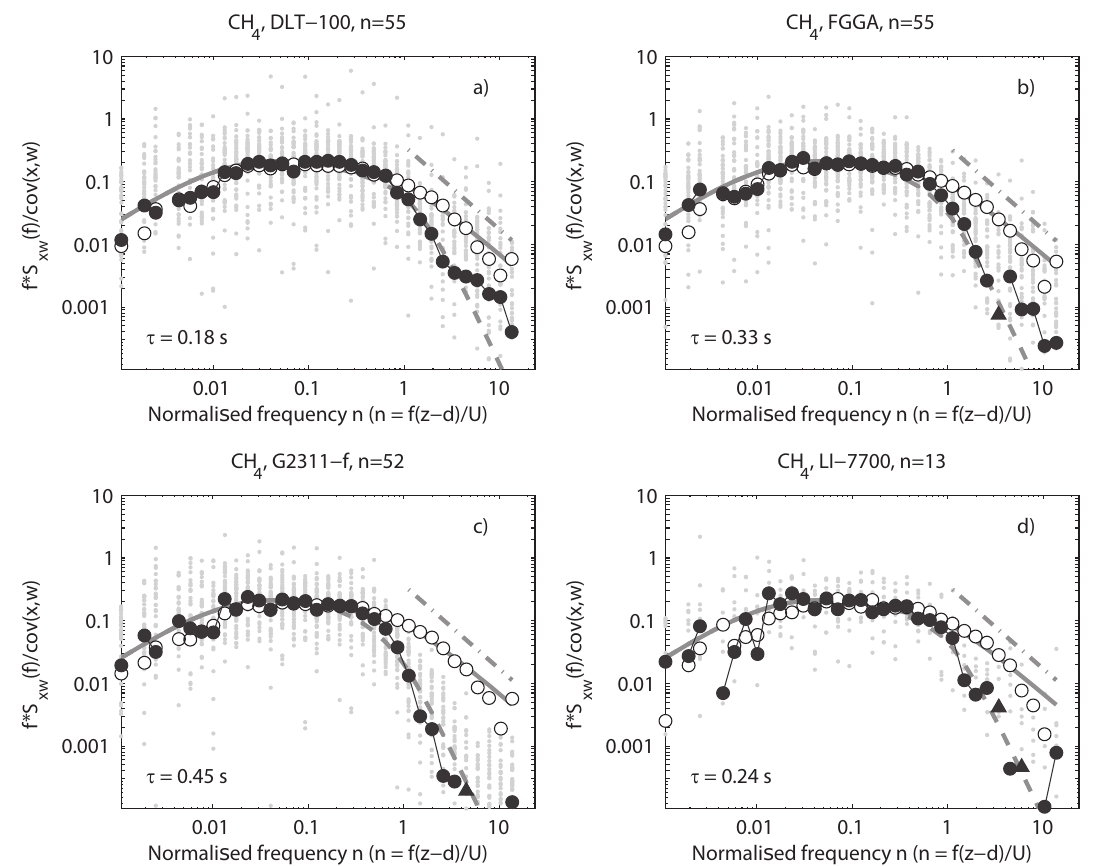
Figure 6. Normalised frequency-weighted CH 4 cospectra between CH 4 and vertical wind velocity for the different instruments associated with the METEK1 anemometer (black dots show positive values, black triangles negative values), corresponding temperature cospectra (white dots), theoretical slope − 4/3 in the inertial subrange (dash-dotted line), model cospectrum (grey line) and model cospectrum multiplied by transfer function describing high-frequency attenuation, Eq. (3) (dashed grey line). Response time describing high-frequency attenuation is given in the figure for each gas analyser. Small grey dots show individual cospectra from which the mean cospectrum (black markers) is calculated. For this figure data were selected from the period 19 to 27 June, using only unstable periods when (a) CH 4 flux was directed upwards, (b) wind speed was between 2ms − 1 and 6ms − 1 , (c) CH 4 fluxes were flagged with quality flag 0 and (d) more than 60% of the points in the normalised cospectra were positive. The LI-7700 data are affected by an external data-logging problem which is not caused by the